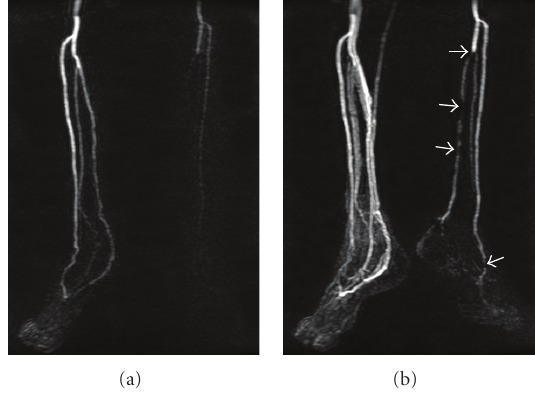
Figure 1: A 60-year-old man with unhealed ulcers over the left heel region for 4 months. (a) T-MRA with MIP reconstruction at 36s after contrast medium injection demonstrating peak arterial enhancement of the right distal run-o ff station with clear depiction of infrapopliteal and pedal arteries without venous overlay. The left leg vessels are not poorly opacified. (b) T-MRA at 42 s time frame demonstrating peak arterial enhancement of the left leg with multiple significant stenoses (arrows) in the left posterior tibial artery and dorsalis pedis and nonopacification of planter artery. The right leg is obscured due to prominent venous contamination. Without a time-resolved approach, clear depiction of infrapopliteal and pedal vessels would have been di ffi cult due to discrepant arterial